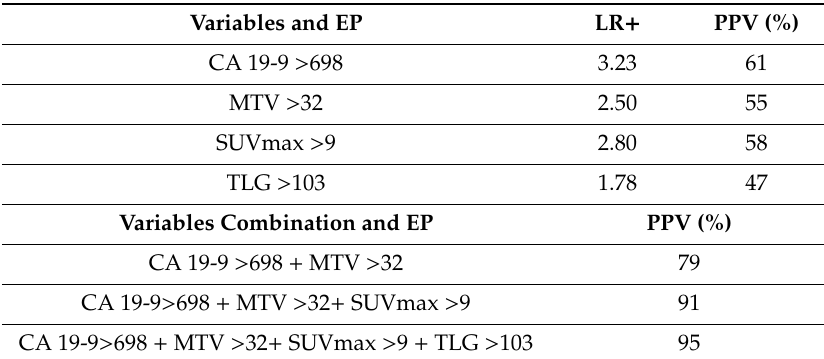
Table 3. Predictors of Early Progression (EP). The variables analyzed were CA 19-9, the maximum standardized uptake value (SUVmax), the metabolic tumour volume (MTV), the total lesion glycolysis (TLG) of primary tumours. LR + , likelihood-ratio positive; PPV, Positive Predictive Value.